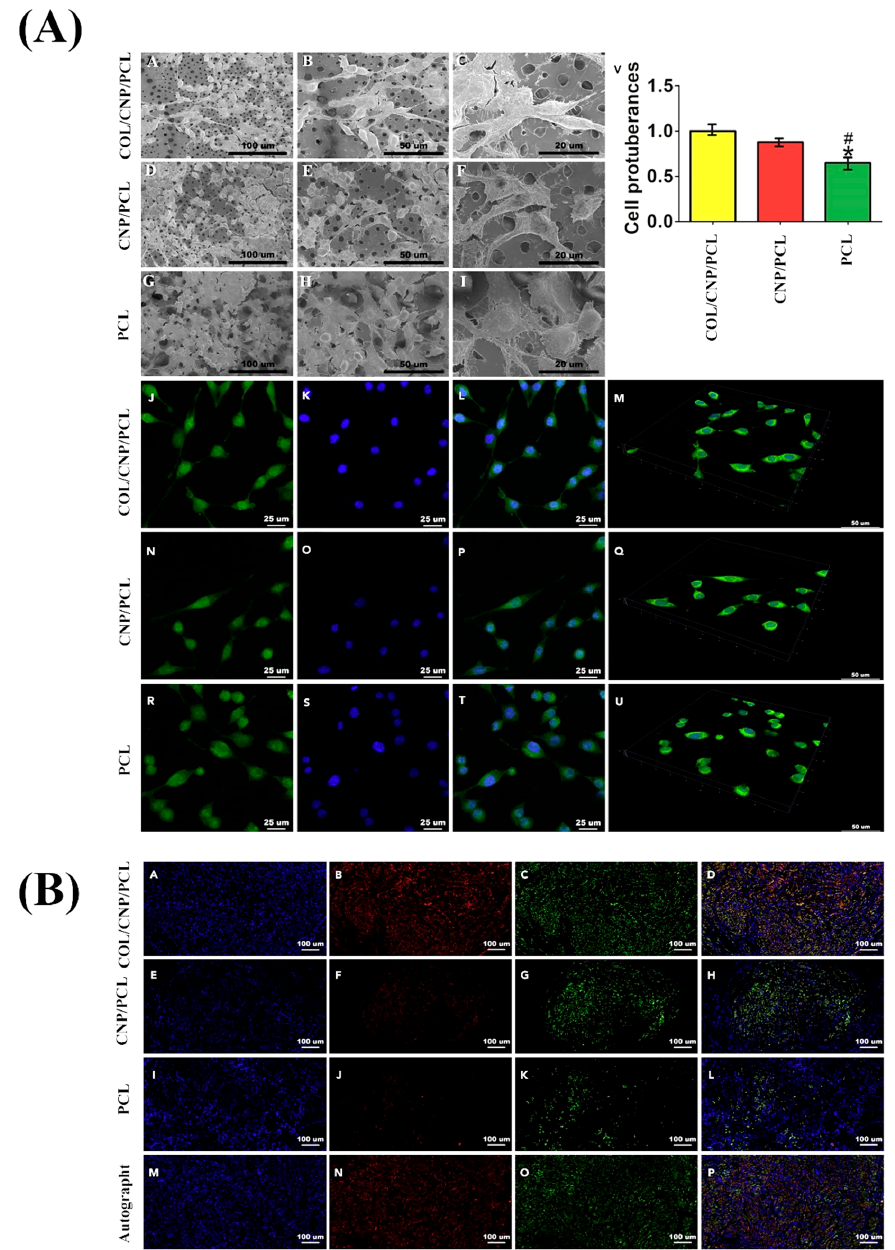
Figure 5. ( A ) Micrographs exhibiting Schwann cell morphology in different conduits captured by scanning electron microscope (SEM) (A–I) and immunofluorescence microscope (J–U). Note that the